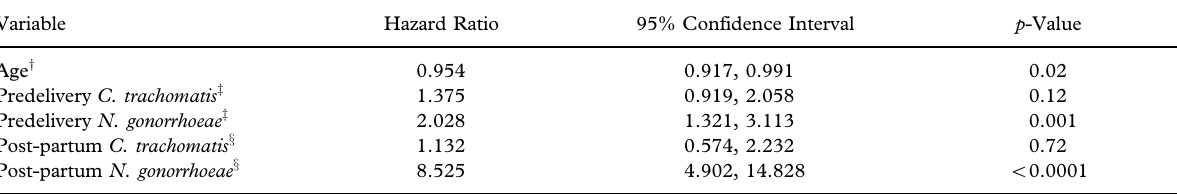
Table III. Survival analysis of time to PID after delivery, examining the effects of chlamydial and gonococcal infection on the time to occurrence of PID after adjustment for covariates ( n =14 156 * ).